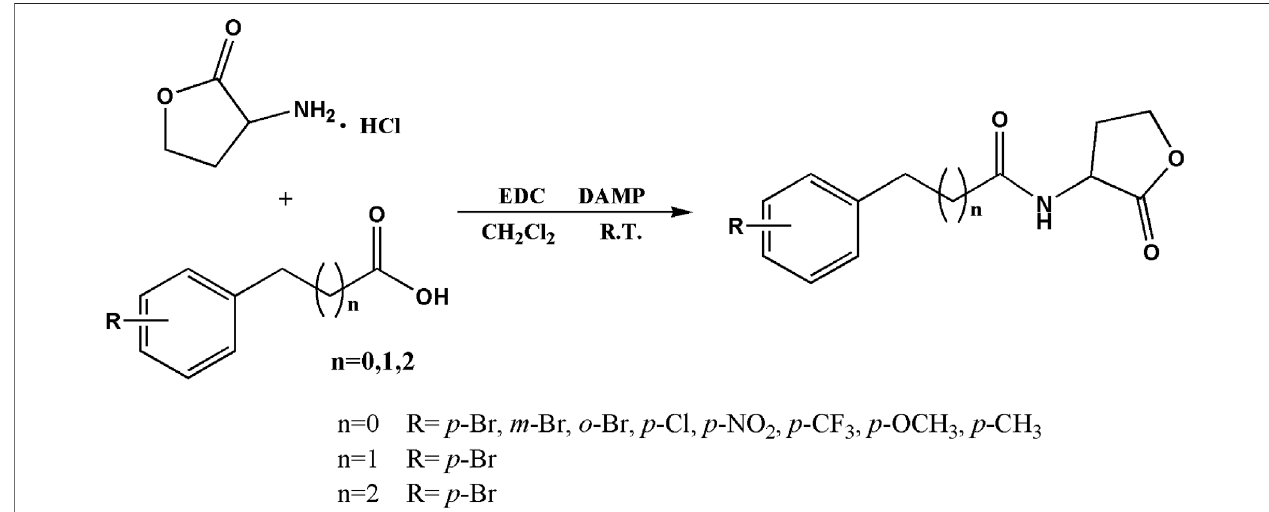
FIGURE 2 | Synthesis of AHL analogs. RT = room